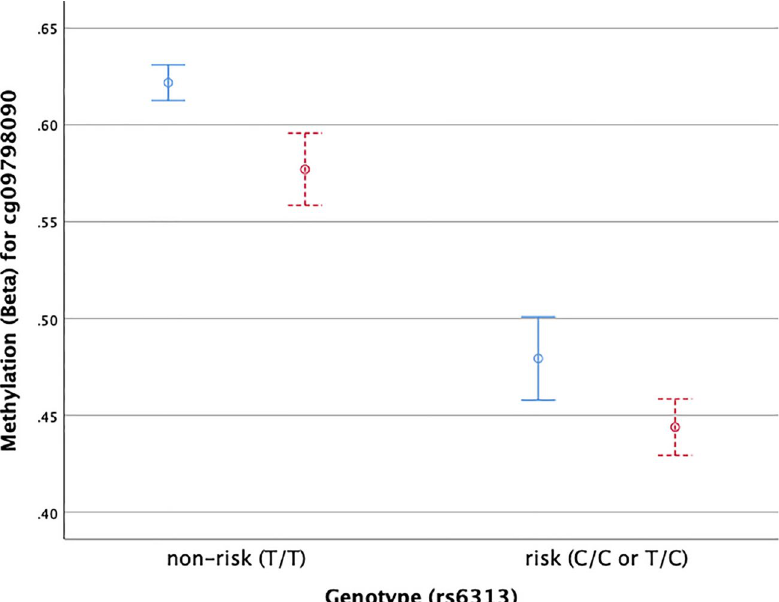
Figure 3. HTR2A mQTL. Mean delta beta values at cp09798090 for SNP rs6313 in either the non-risk allele (T/T) or risk allele (C/C or T/C). Healthy controls (HC) are shown in blue, SPMS are shown in read. Error bars are standard error of the